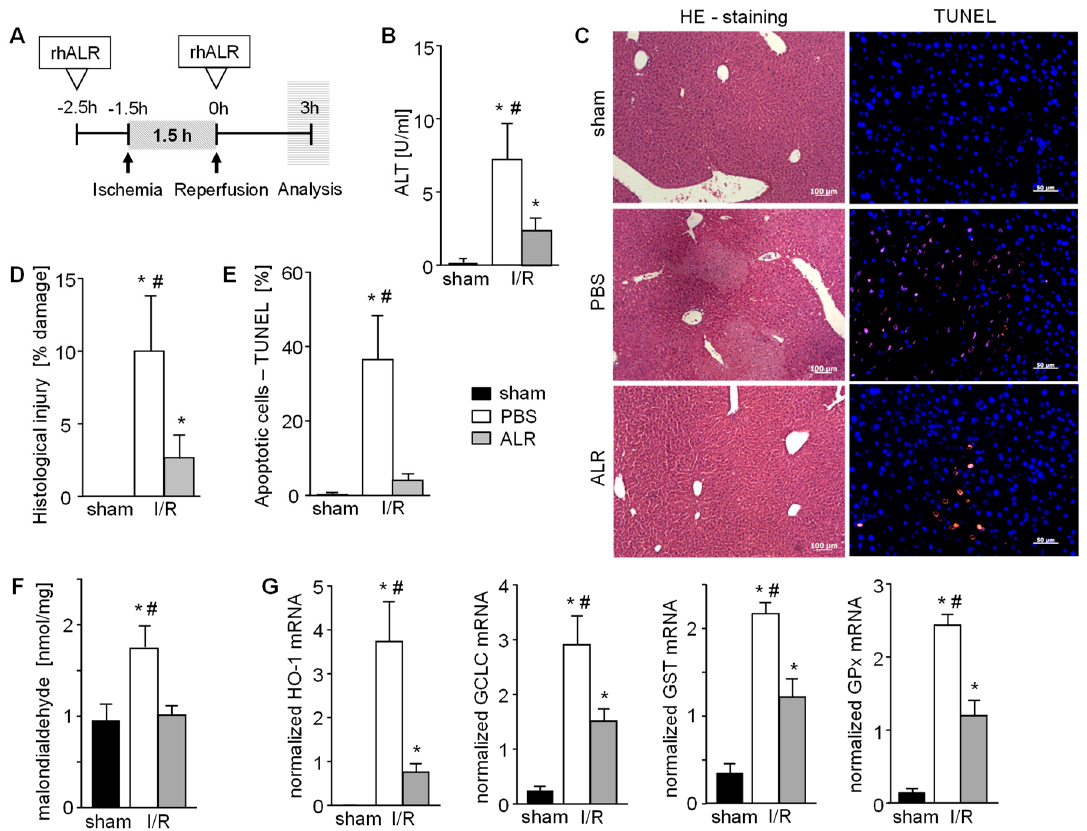
Figure 1. Augmenter of liver regeneration (ALR) reduces hepatic cell damage in a mouse model of ischemia reperfusion injury (IRI). ( A ) Schematic illustration of applied ischemia reperfusion (IR) mouse model. Mice were treated with ALR (100 µg/kg b.w.) at 2.5 h before ischemia (1.5 h) and beginning of reperfusion (3 h) ( n = 6). ( B ) IR induced liver damage after 3h reperfusion was analyzed by quantification of ALT serum levels, histological examination of ( C , D ) necrotic areas performing H/E staining and ( C , E ) determination of apoptotic cells performing TUNEL assay ( n = 6). ( F ) Oxidative stress as a marker of IRI in liver tissues after 3h reperfusion was analyzed by quantification of malondialdehyde (product of lipid peroxidation, normalized to sham) and ( G ) mRNA expression of anti-oxidative genes (HO-1, GCLC, GST, and GPX) reflecting cellular response to reactive oxygen species (ROS) ( n = 5). Gene expression was normalized to 18S. * p < 0.05 or # p < 0.05 differs from sham or IR/ALR, respectively.